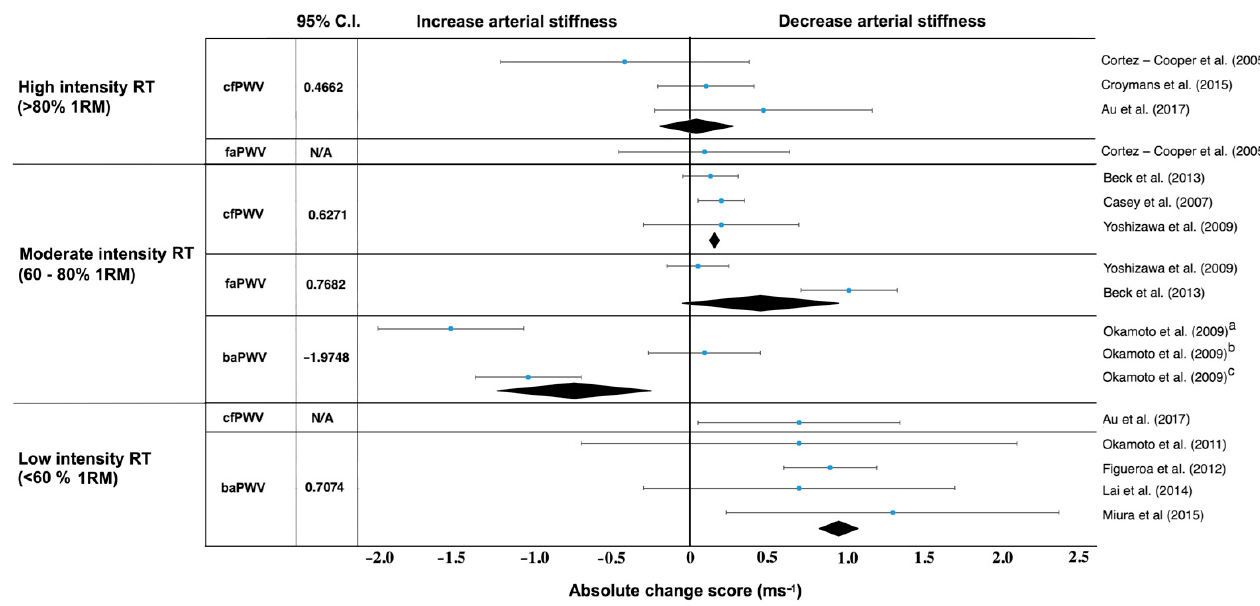
Figure 2. Carotid–femoral pulse wave velocity changes.